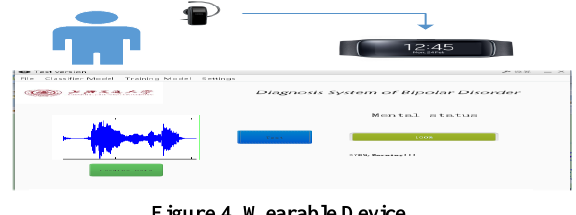
Figure 2. Feature assessment.